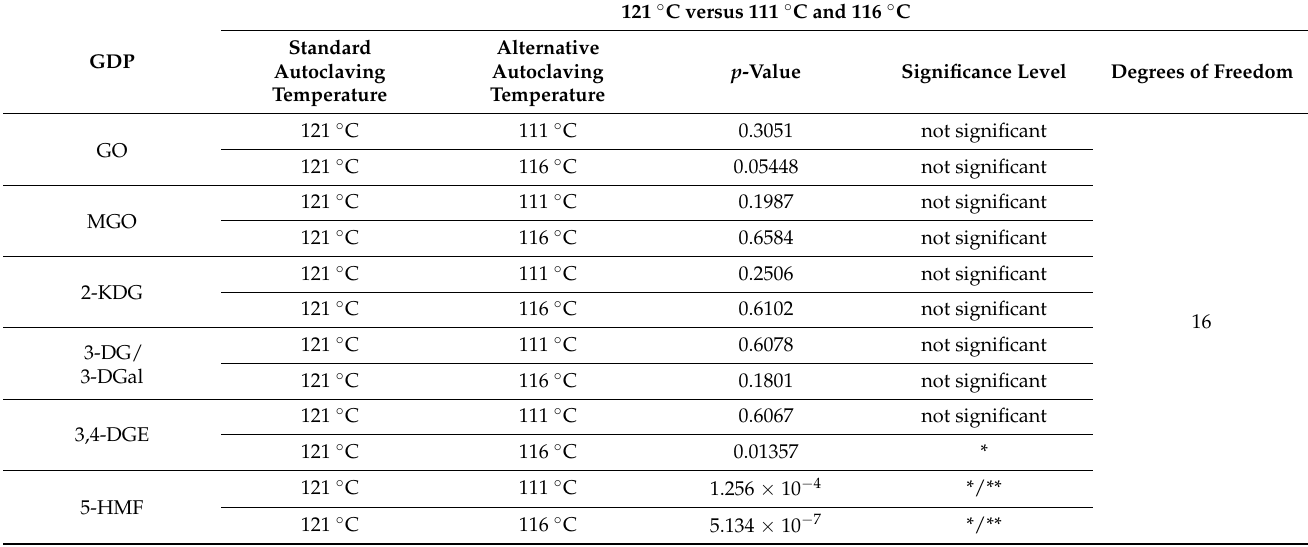
Table 13. Comparison of GDP concentrations at 121 ◦ C versus the two alternative autoclaving temperatures 116 ◦ C and 121 ◦ C in autoclaving scheme A.